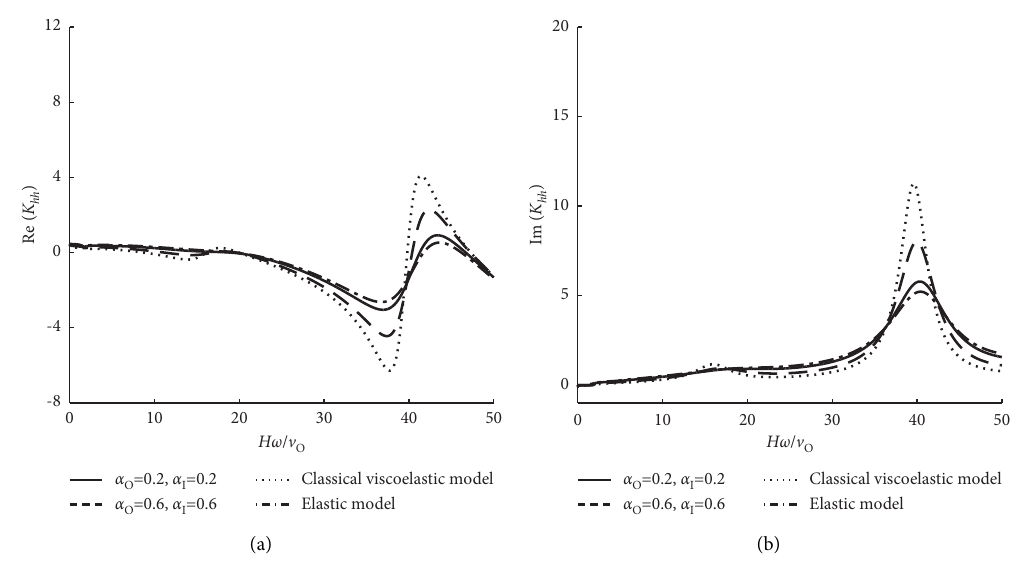
Figure 11: The horizontal dynamic impedance curves of pipe pile under different soil models. (a) Real part of horizontal dynamic impedance. (b) Imaginary part of horizontal dynamic impedance.